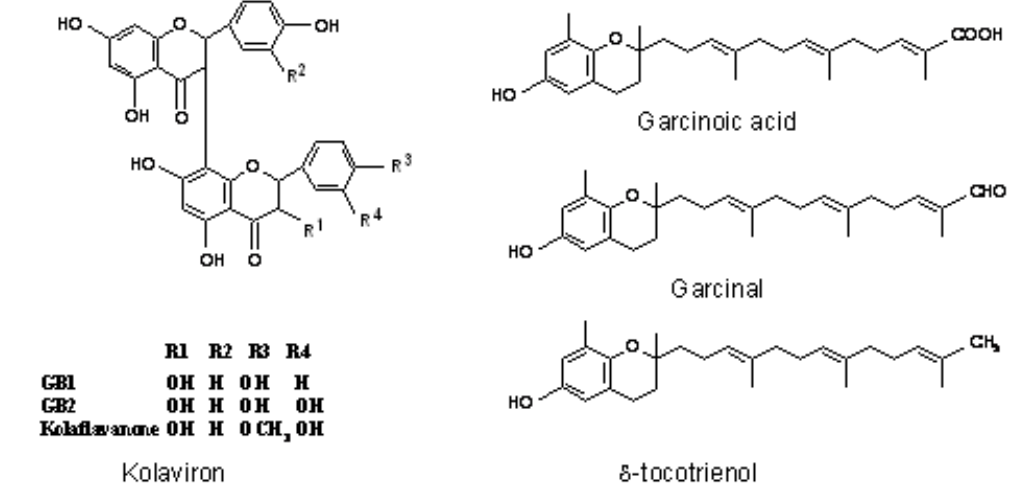
Figure 4. Chemical Structure of compounds isolated from Garcinia kola.